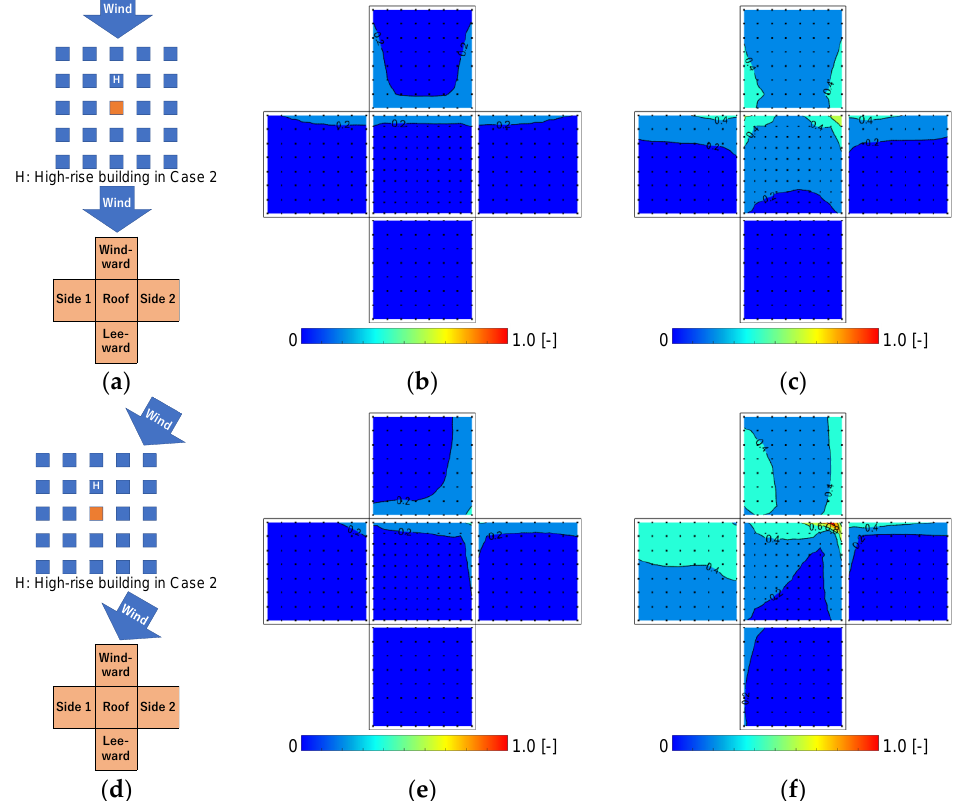
Figure 10. Fluctuating wind pressure coefficient 𝐶 𝑝′ ; ( a ) building model arrangement and prevailing wind direction for ( b , c ); ( b ) wind direction of 0° in Case 0 with no high-rise building; ( c ) wind direction of 0° in Case 2 with a high-rise building next to the pressure measurement model; ( d ) building model arrangement and prevailing wind direction for ( e , f ); ( e ) wind direction of 30° in Case 0; ( f ) wind direction of 30° in Case 2.